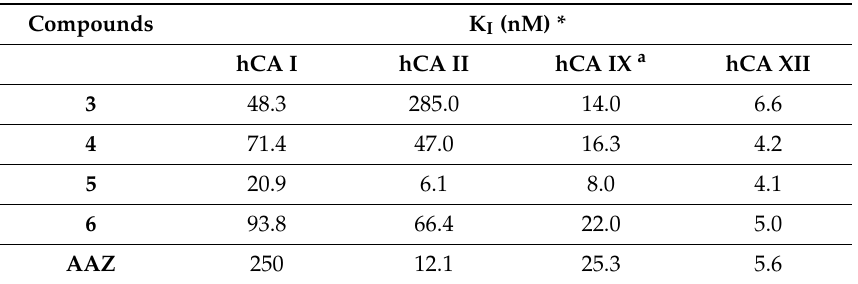
Table 1. Carbonic anhydrase inhibitory data with compounds 3–6 and acetazolamide (AAZ) as